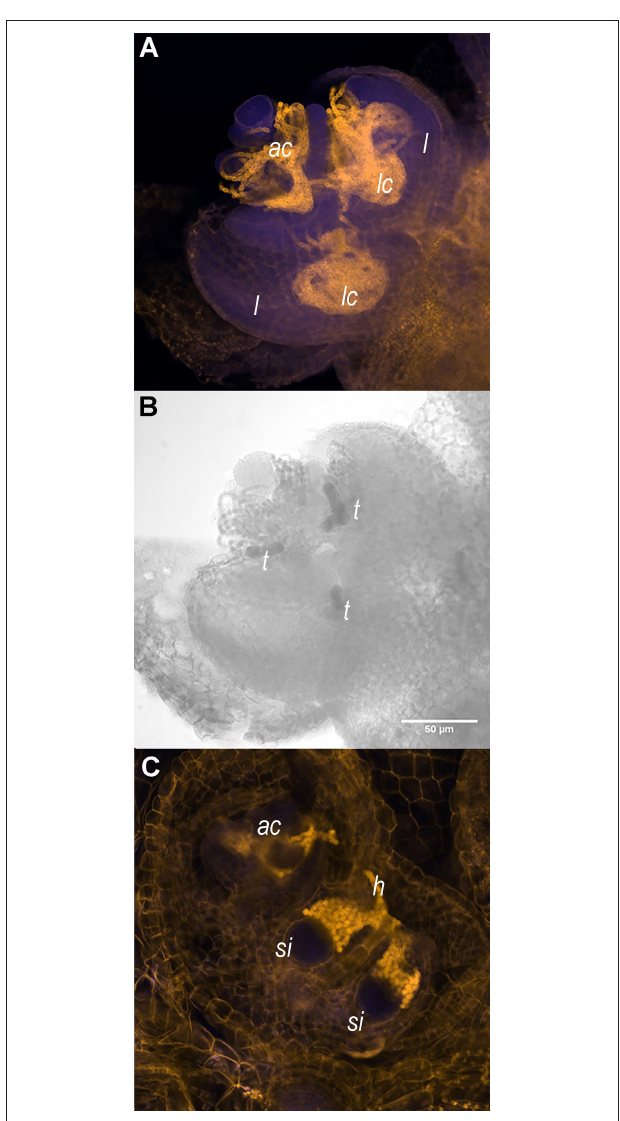
FIGURE 1 | Shoot apices of Azolla filiculoides sporophytes contain the apical Nostoc azollae colony, trichomes, and sporocarp initials. (A) Shoot apex with apical N. azollae colony ( ac ). Outer leaves were removed for a better visualization of developing leaf lobes ( l ), leaf cavities ( lc ), and bacteria filaments. (B) The same shoot apex as in (A) with trichomes ( t ) revealed by transmitting light absorption surrounded by the apical colony and in areas destined to form leaf cavities ( lc ); Bar: 50 µ m. (C) N. azollae hormogonia ( h ) invading the sporocarp initials ( si ). Sporophytes were stained with propidium iodide (Truernit et al., 2008), then the fluorescence was detected using 405nm activation beam, and emission < 560nm filter for the yellow channel and 505–530nm for the blue channel with the Confocal Laser Scanning microscope Zeiss LSM5